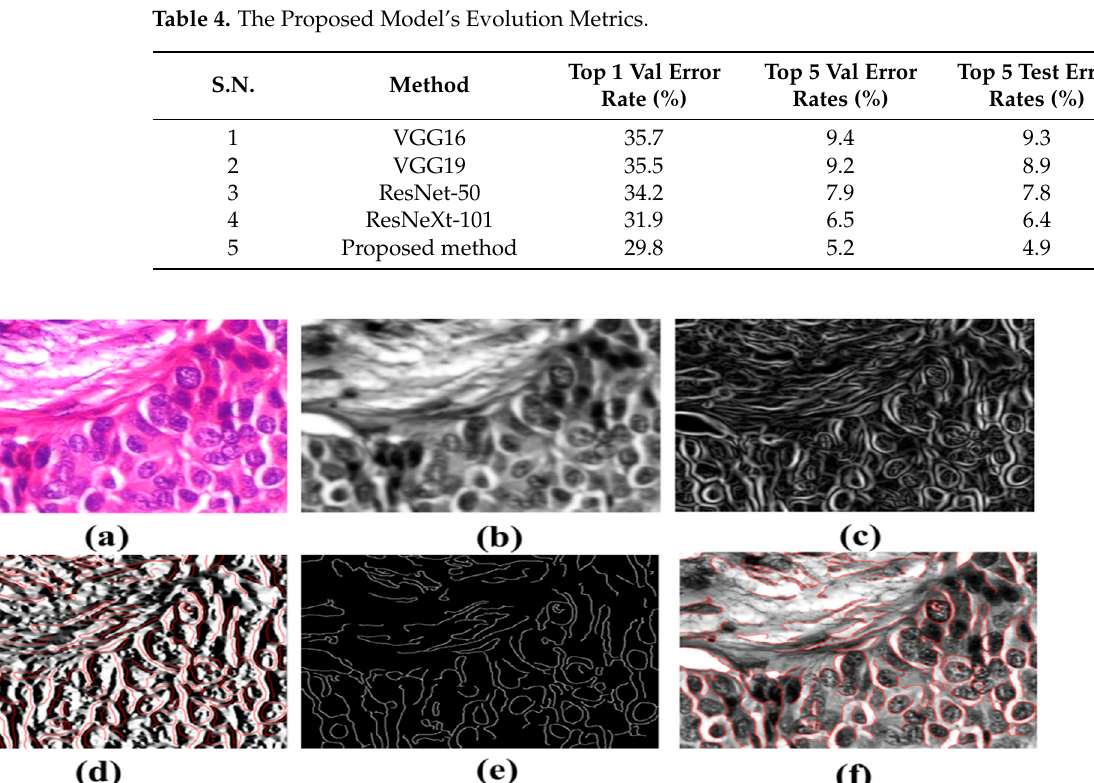
Figure 8. Detection of Breast Cancers. ( a ) Input H&E Image ( b ) image after gaussian smoothing ( c ) It is the gradient magnitude it is determining in which direction the change in intensity is pointing ( d ) Gradient in the X direction ( e ) It is the non-maximum suppression for the detection of edges of cancerous cells ( f ) Image with minor contours and features. Table 4. The Proposed Model’s Evolution Metrics.